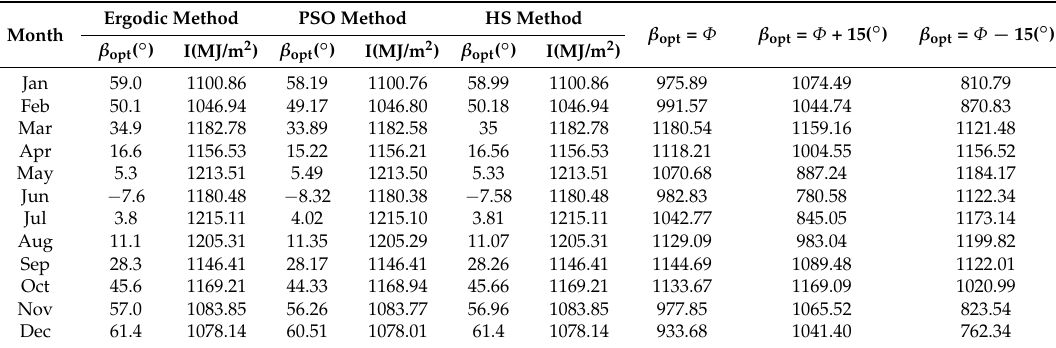
Table 3. Comparison of results of Shanghai using several